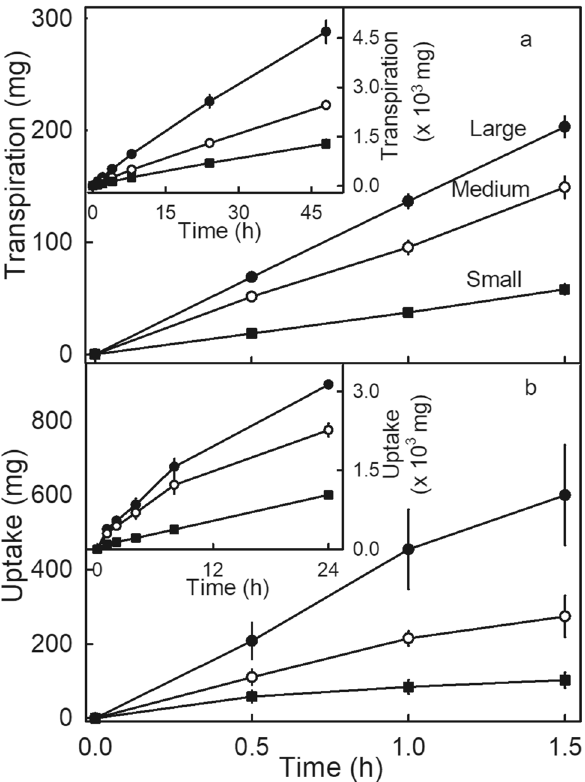
Figure 1. Short-term (main graph) and long-term (insets) time course of ( a ) transpiration and ( b ) water uptake of large, medium, and small strawberry fruit (cv.